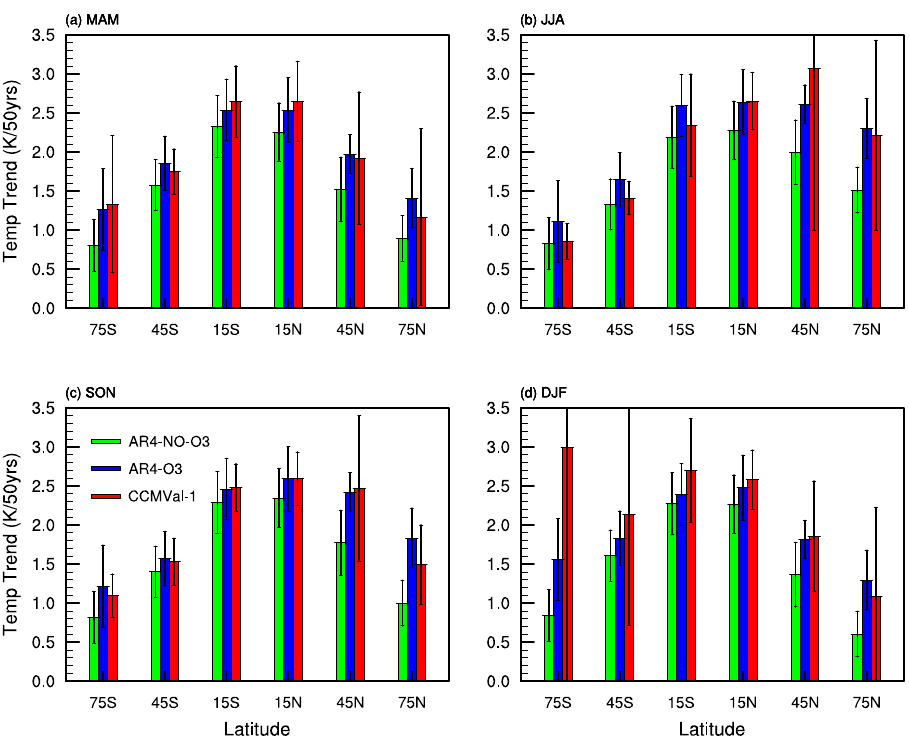
Fig. 9. Comparison of zonal-mean temperature trends at 300hPa by latitude over 2001–2050. (a) MAM, (b) JJA, (c) SON and (d) DJF.